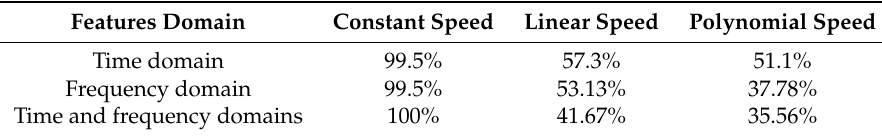
Table 6. Accuracy of the SVM with different feature